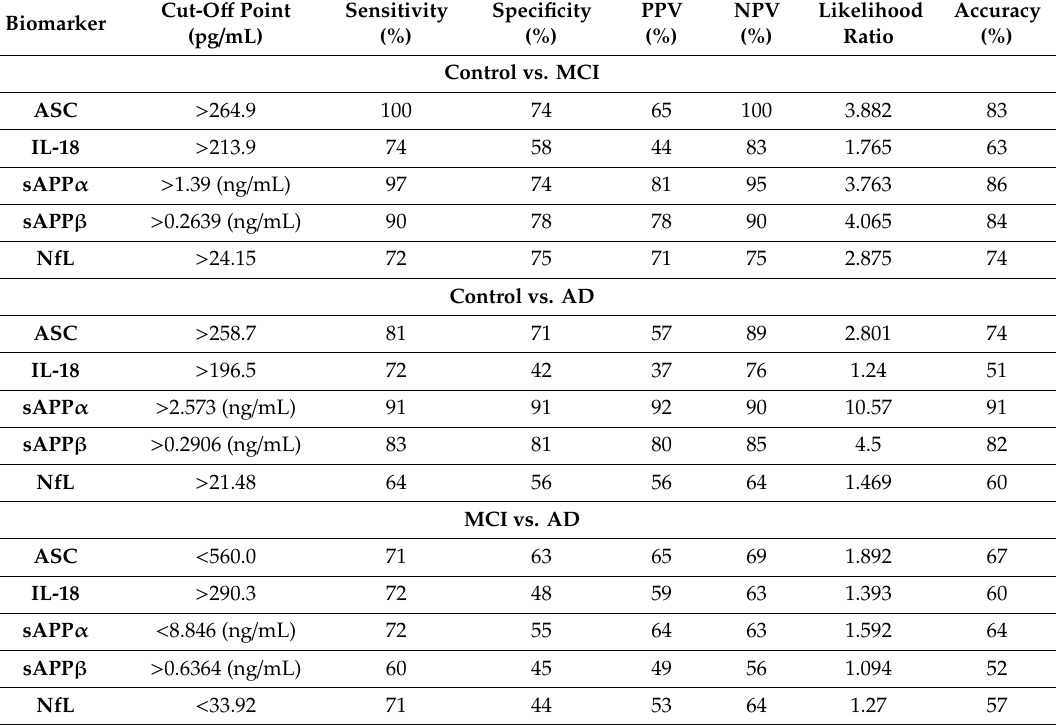
Table 2. Sensitivity and specificity. PPV: positive predictive values and NPV: negative predictive